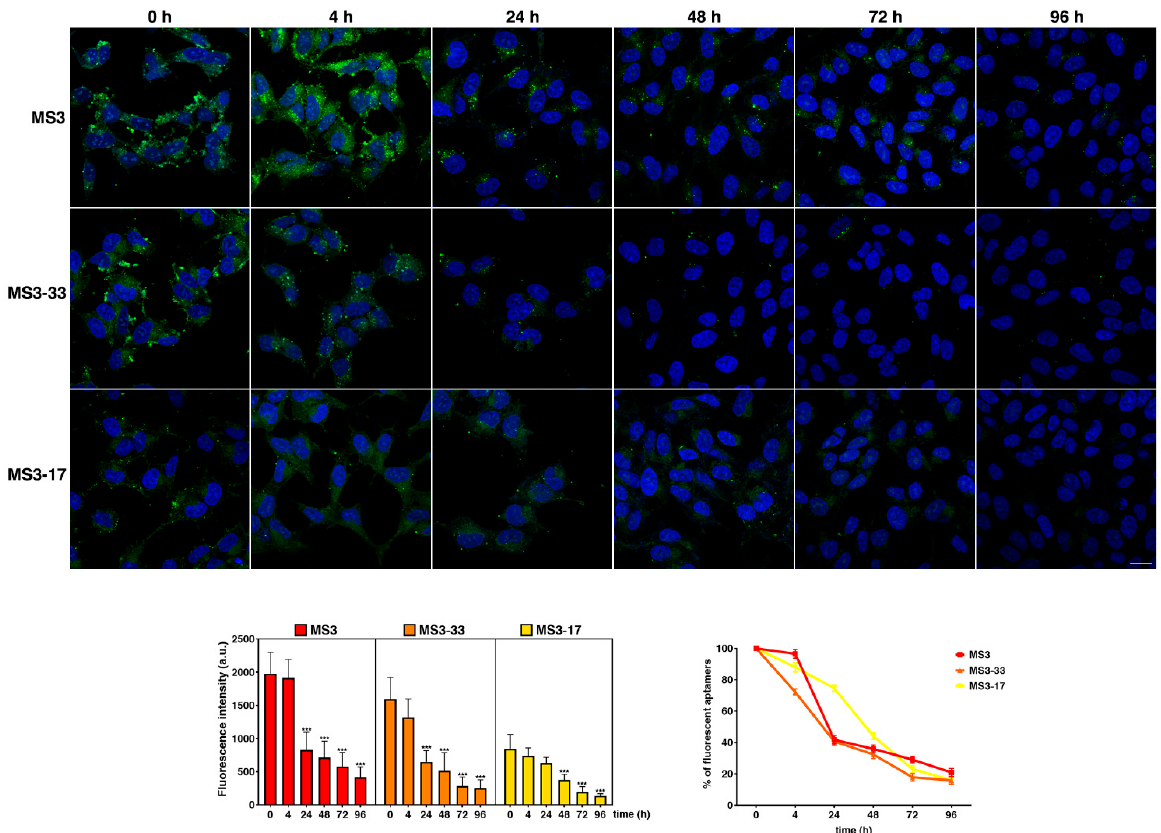
Figure 9. Analysis of the biological stability in SH-SY5Y cells of MS3 and its analogues by time-course experiments. SH-SY5Y cells were incubated for 24 h with FITC-conjugated aptamers (green). After the removal of the residual aptamers by extensive washings, cells were incubated in a culture medium for the different indicated times. Nuclei were stained with DAPI. Images were acquired with a confocal microscope. Scale bar, 6 μ m. Mean fluorescence intensity was measured at the different time points and expressed as an arbitrary unit (a.u.; left graph) or as the percentage of fluorescence detected at time 0 (set to 100%; right graph); error bars, mean ± SD; n > 40 cells. *** p < 0.001, Bonferroni test after significant ANOVA. Note that there is a statistically significant difference between the 72 and 96 h time points for MS3 but not for MS3-33 and MS3-17 ( p -value < 0.001, Bonferroni test after significant ANOVA).